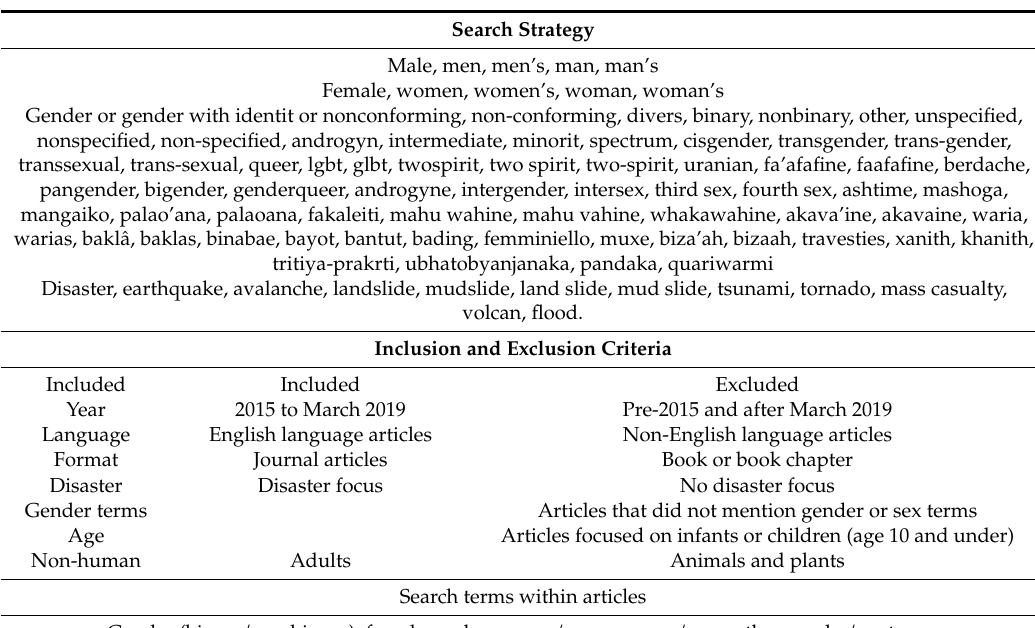
Table 1. Search strategy inclusion and exclusion